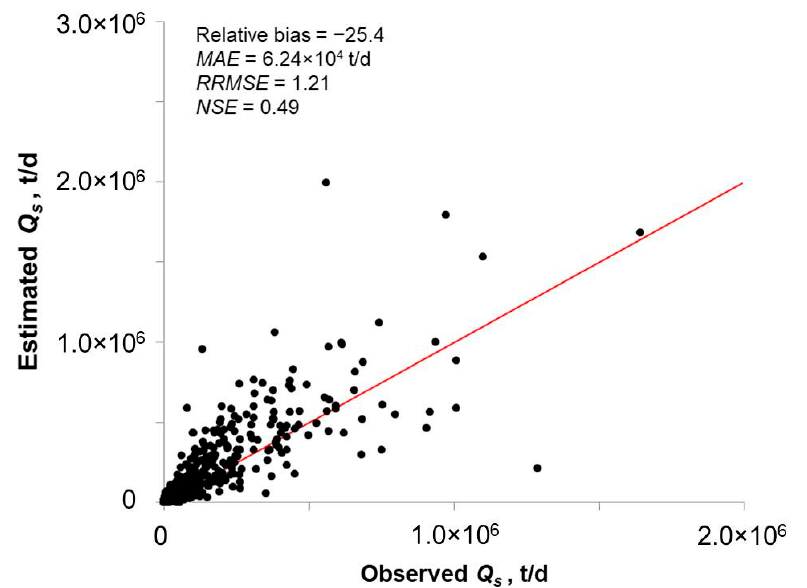
Figure 12. Overall performance of the sediment discharge estimation for the nine study sites in the Upper Mississippi River. The red line denotes the 1:1 relationship.